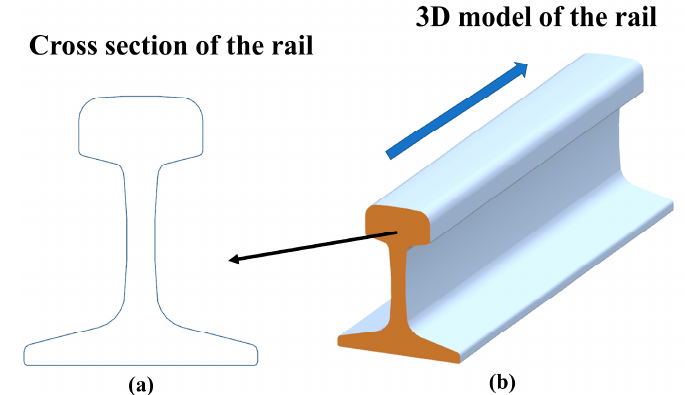
Figure 3. The geometry of the undamaged rail. ( a ) The cross section of the rail; ( b ) 3D model of the rail.